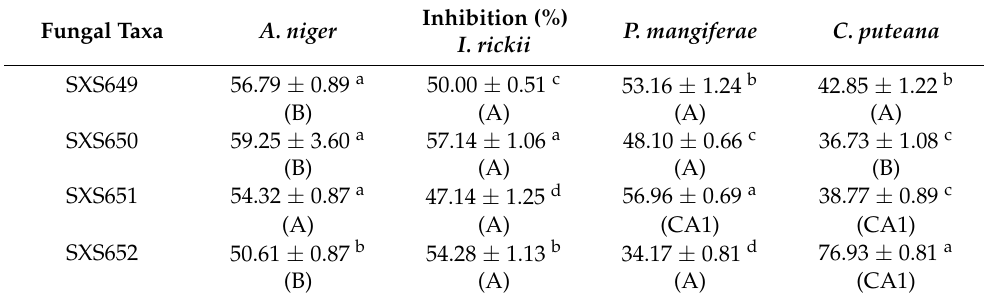
Table 5. Antagonistic action of the endophytic fungi Colletotrichum sp. SXS649, Pestalotiopsis sp. SXS650, Botryosphaeriales SXS651, and Diaporthe sp. SXS652 isolated from P. rigida Kunth against phytopathogenic fungi A. niger SXS635, I. rickii SXS37, P. mangiferae SXS647, and C. puteana